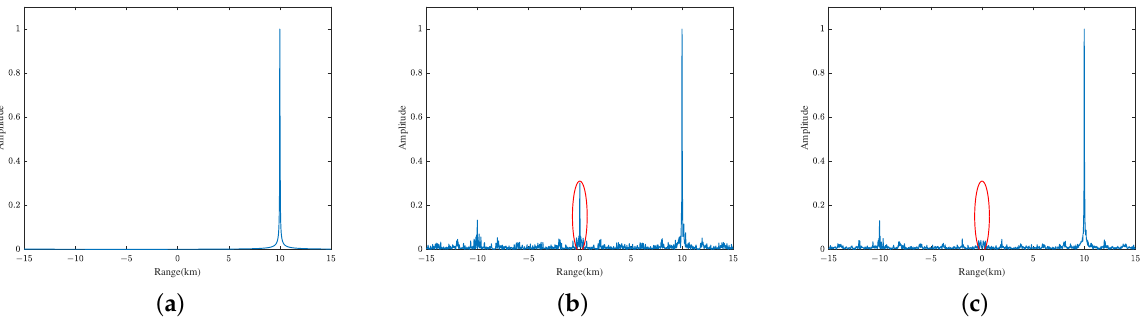
Figure 4. The range profiles of a point target located at 10 km with a low oversampling rate set to 3. ( a ) Results with high-precision quantization. ( b ) Results with one-bit quantization. ( c ) Results with the proposed two-bit